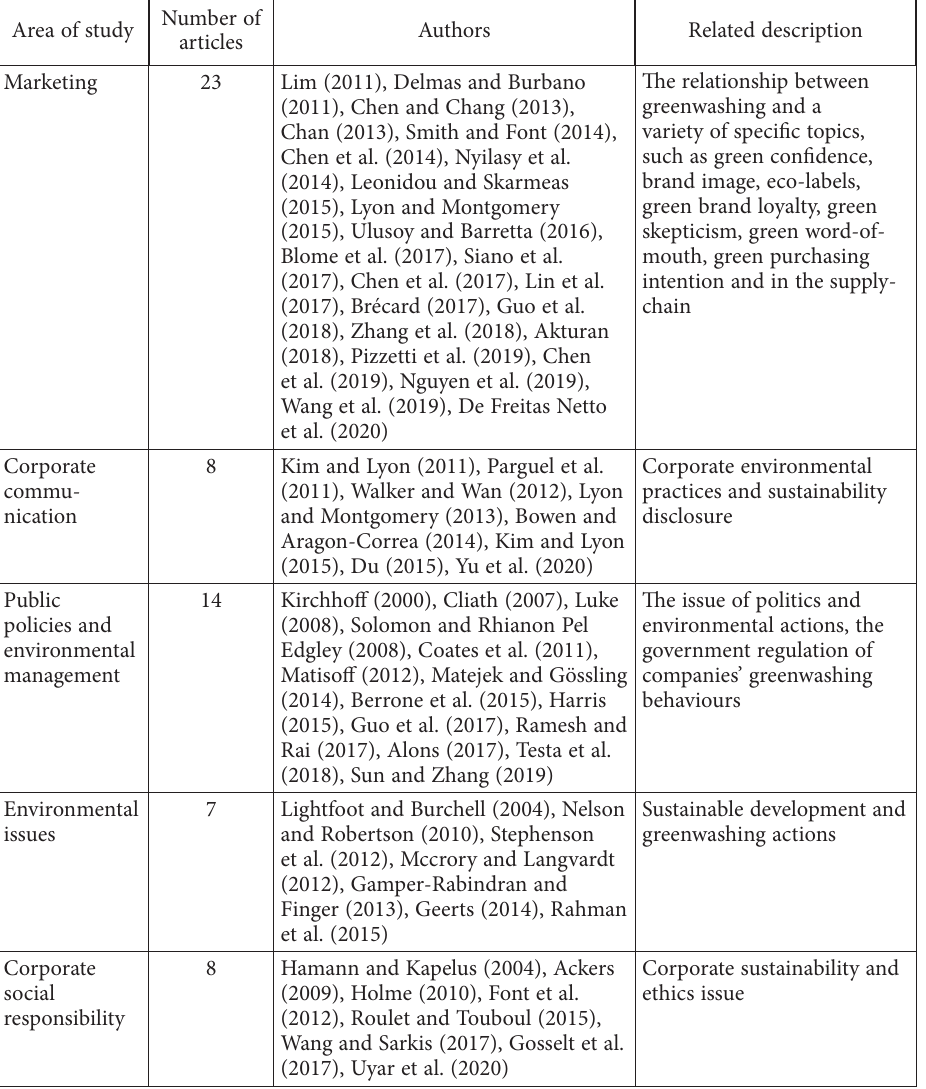
Table 3. Summary of identified topics and related description Area of